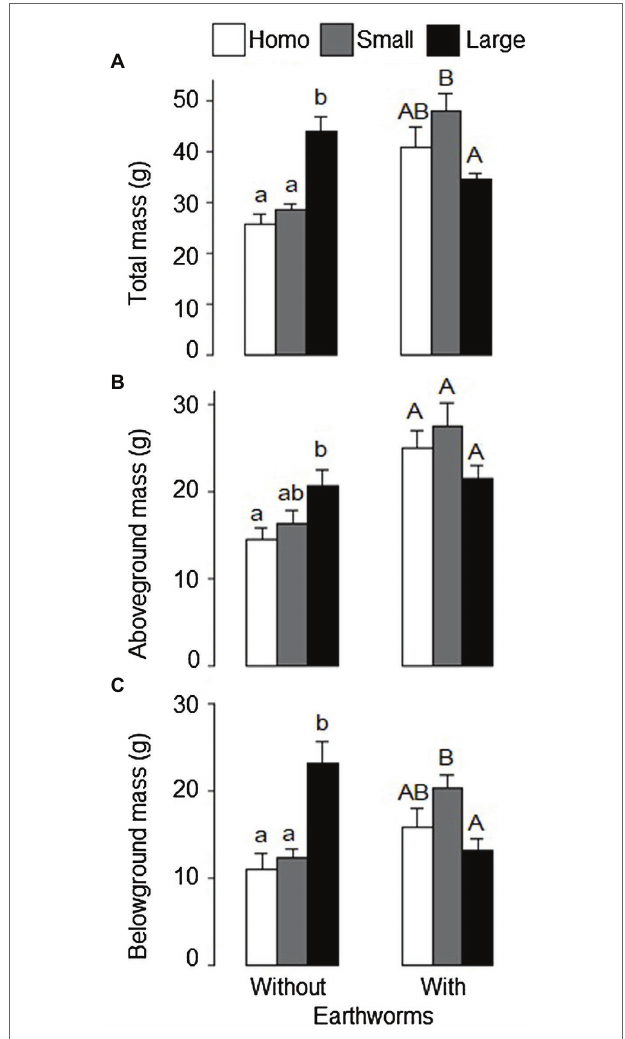
FIGURE 2 | (A) Total, (B) aboveground, and (C) belowground mass of Leymus chinensis under the homogeneous, heterogeneous small patch and heterogeneous large patch treatments with or without earthworms. Mean ± SE ( n = 6) are given. Different letters indicate significant difference within each earthworm treatment (by Tukey